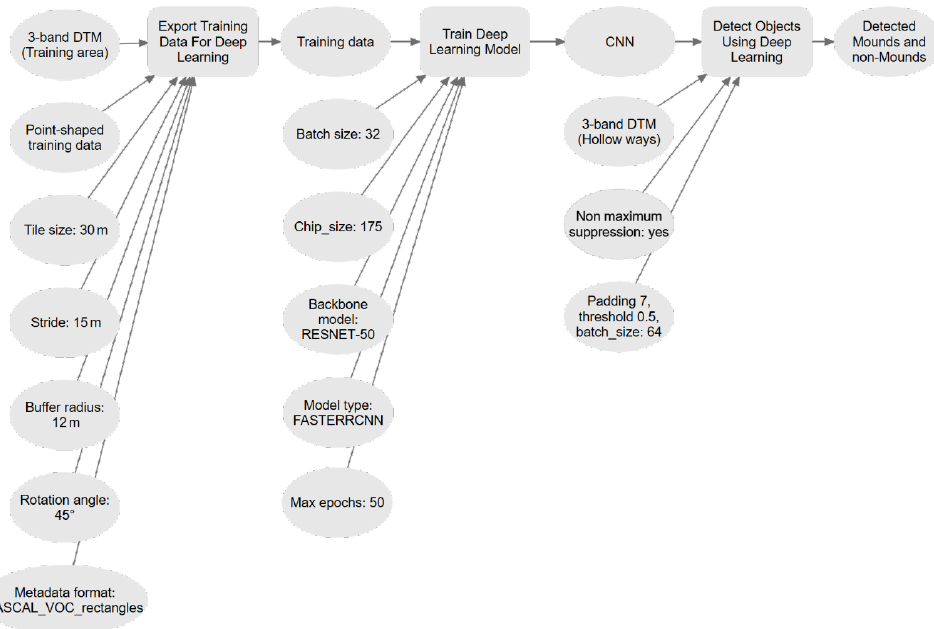
Figure 7. Training and validation loss during training. Training stopped after 25 epochs.